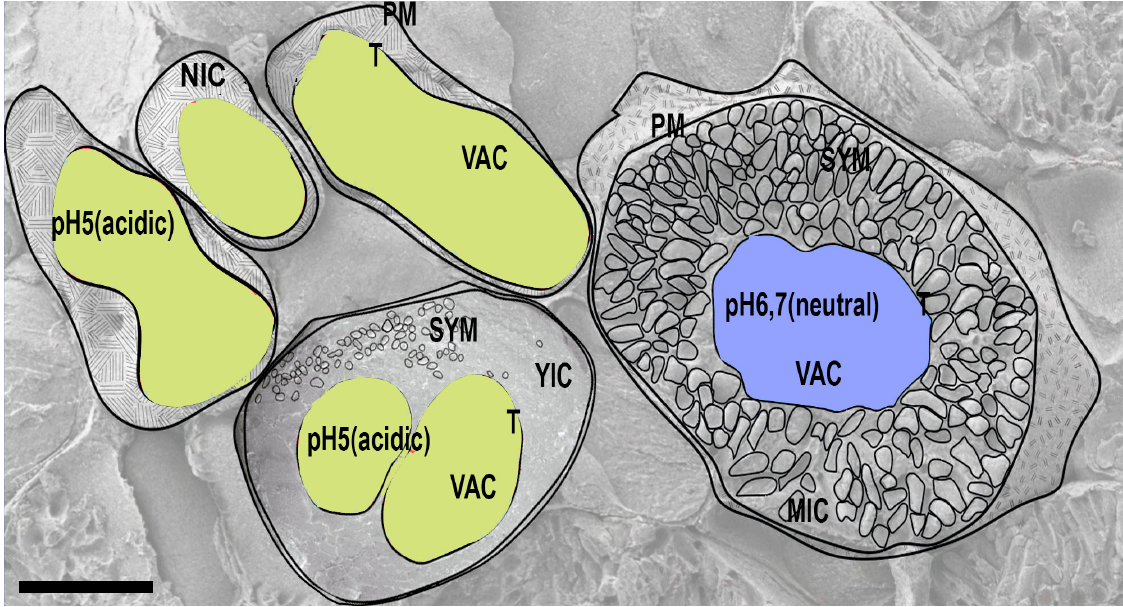
Figure 2. Dynamic changes invacuole pH in non-infected (Non-inf), young infected (YIC), and mature infected (MIC) cells. The vacuoles of mature infected cells lose their acidic pH (marked in yellow) and acquire a neutral pH (marked in blue). Abbreviations: NIC—non-infected cell, YIC—young infected cell, MIC—mature infected cell, Vac—vacuole, T—tonoplast, PM—plasma membrane, SYM—symbiosomes. Bar: 12.5 μ m